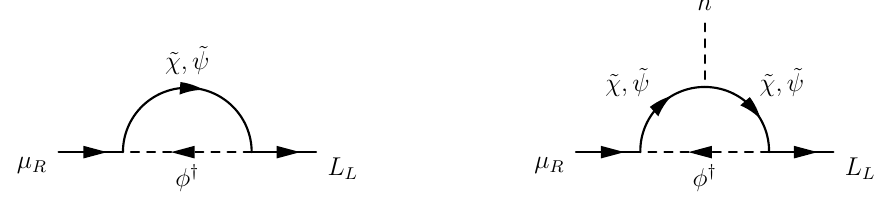
Figure 4 . One-loop diagrams that generate the muon mass and effective Yukawa coupling after electroweak symmetry breaking in the Class 2